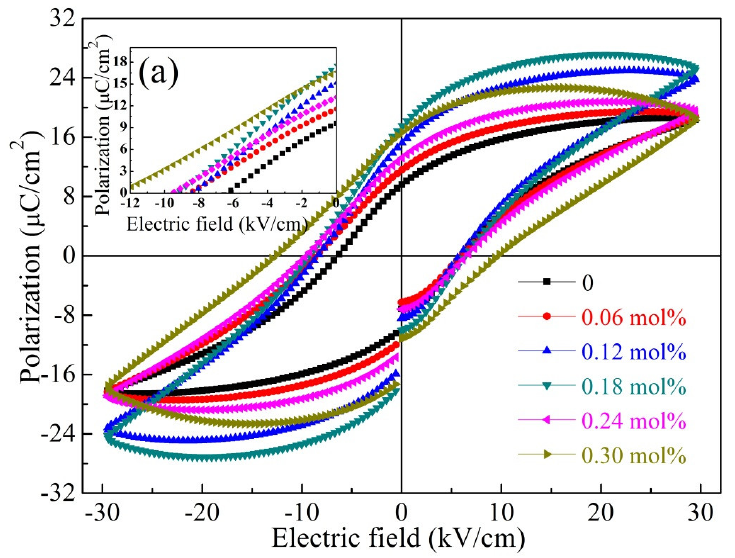
Figure 7. The hysteresis loops of polarisation–electric field ( P-E ) of the BCTZ-NY x ceramics; the inset ( a ) displays the P-E loops of the selected amplified regions (−12 to 0 kV/cm).